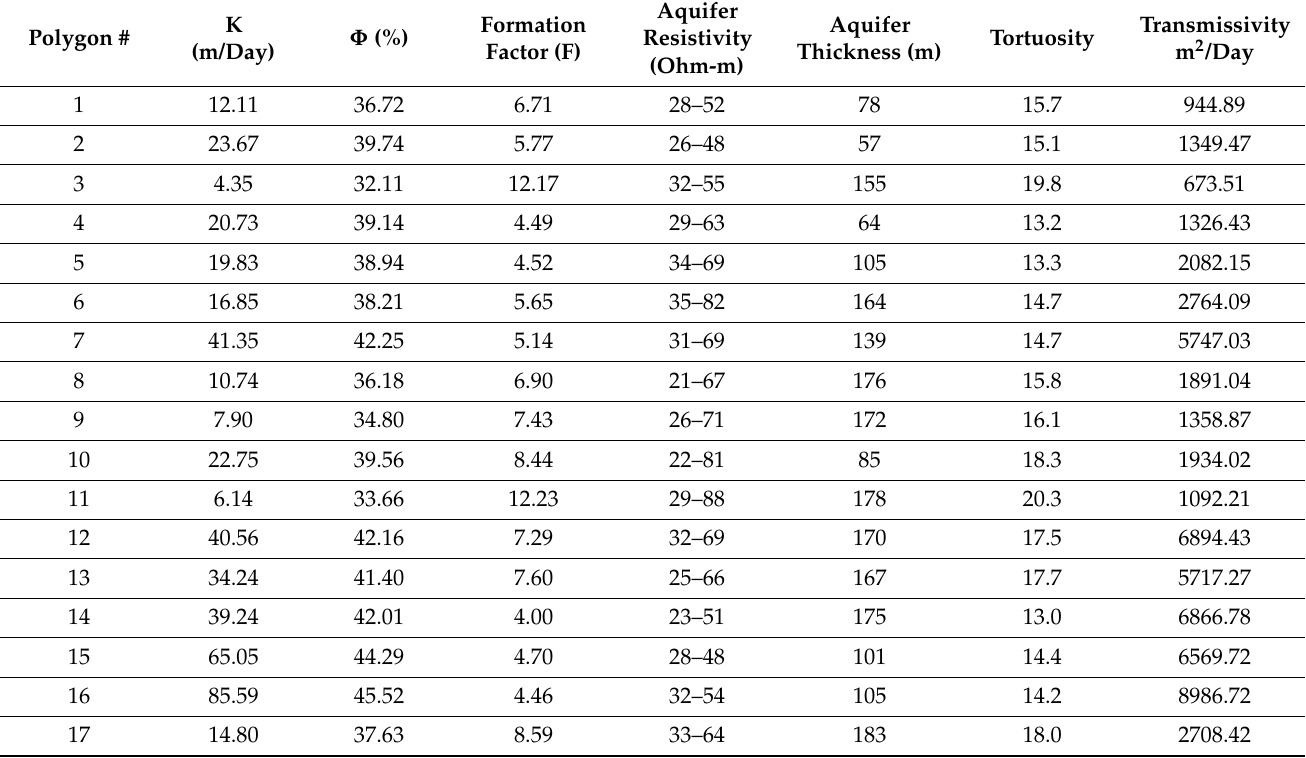
Table 4. Interpreted aquifer parameters based on VES and the estimated hydraulic